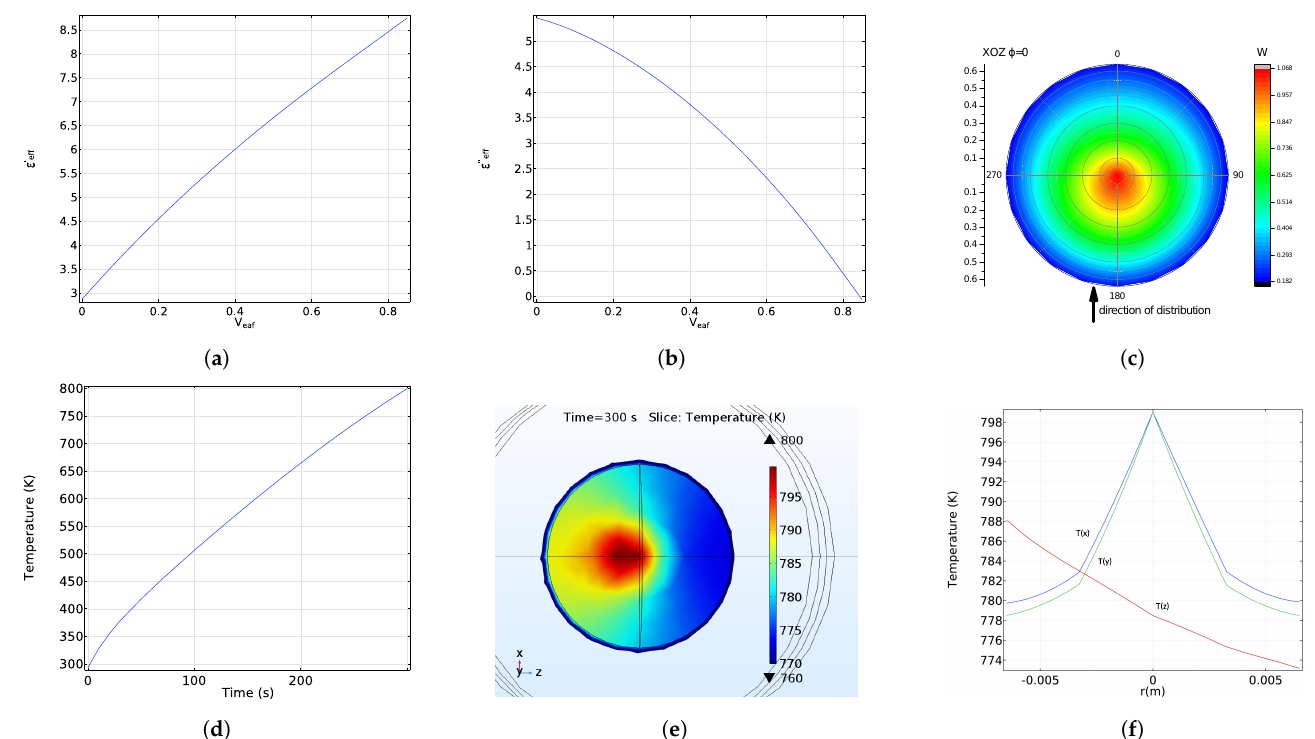
Figure 9. Dependencies of dielectric permittivity (real and imaginary parts) on the volume fraction of EAF dust for a biochar conductivity of σ eaf = 10 10 s − 1 ( a , b ). Distribution of heat sources (analytical solution for plane wave in free space) ( c ), temperature curve ( d ), and temperature distribution within pellet ( e , f ).